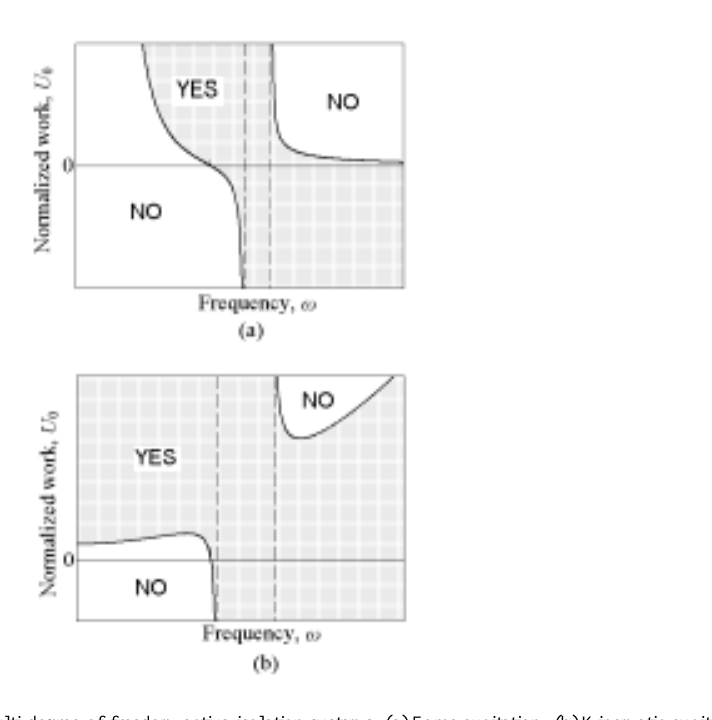
Fig. 6. Limiting performance of multi-degree-of-freedom active isolation systems. (a) Force excitation. (b) Kinematic